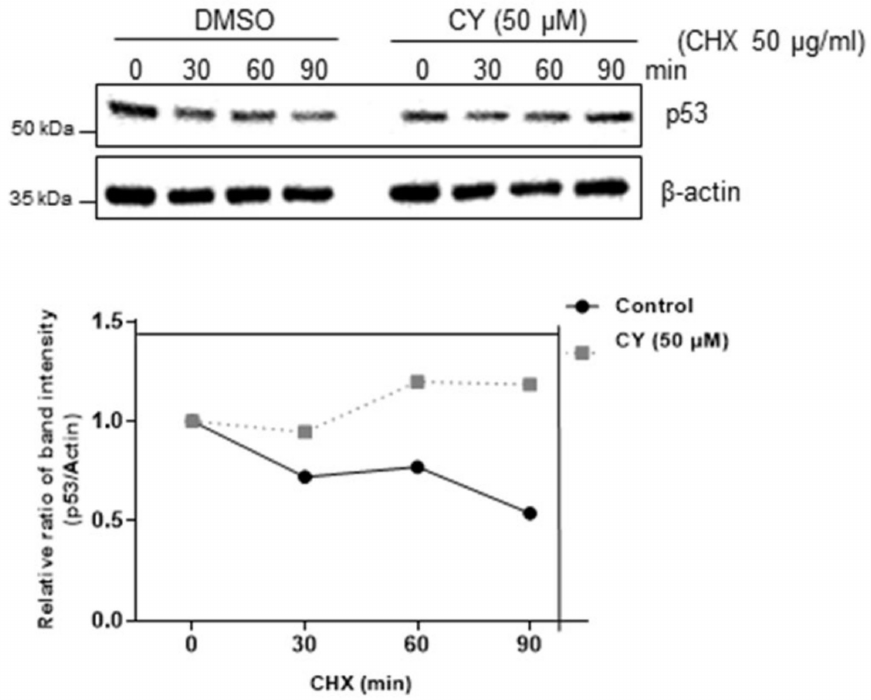
Figure 4. CY inhibits p53 degradation. p53 half-life was maintained in HCT116 p53+/+ cells. HCT116 p53+/+ cells were collected after CY treatment for 24 h for Western blotting with the in- dicated